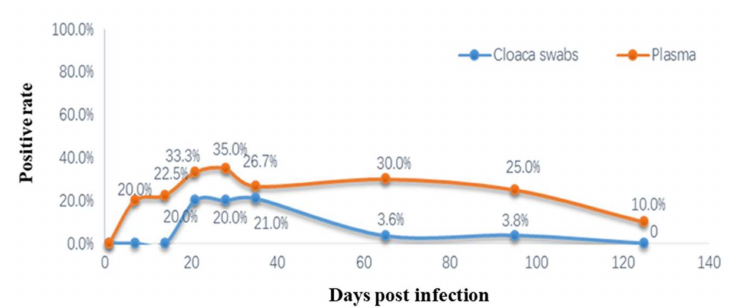
Figure 9. Ratios of samples positive for viremia from the infected groups as detected by plasma virus isolation and cloacal swabs ALV p27